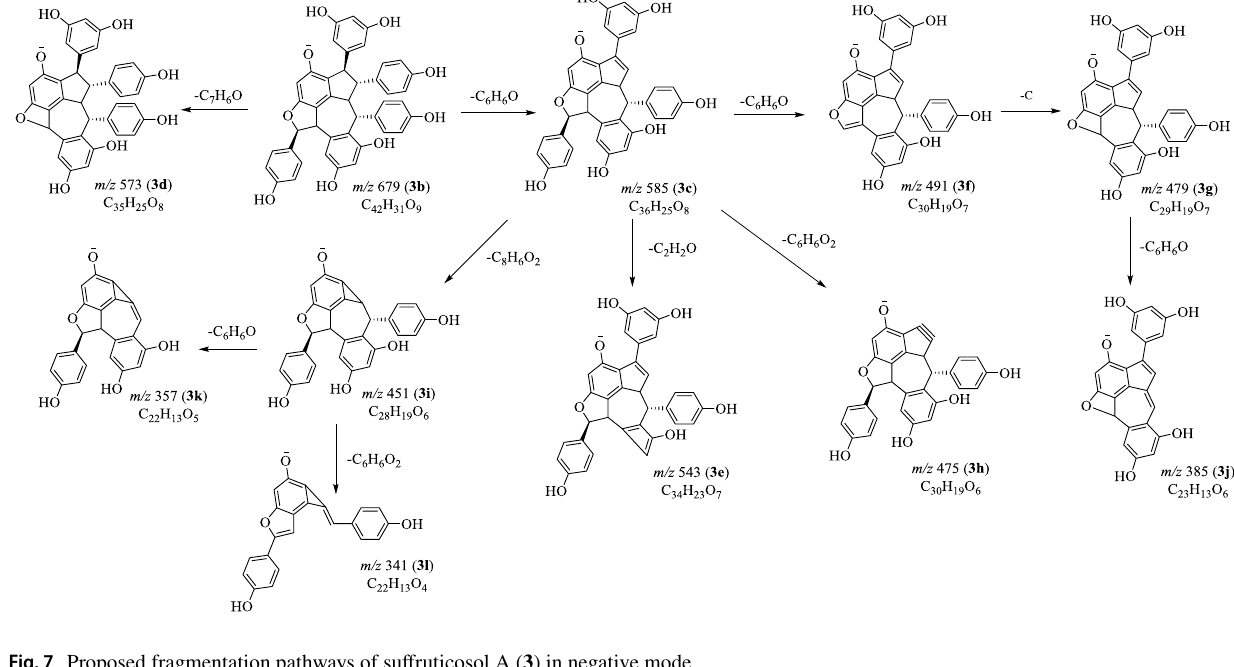
Fig. 7 Proposed fragmentation pathways of suffruticosol A ( 3 ) in negative mode